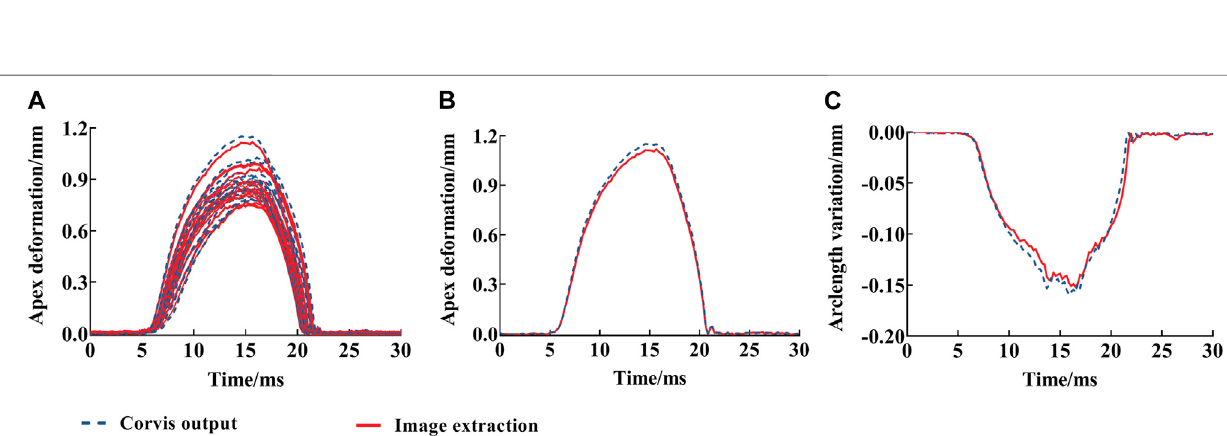
Frontiers in Bioengineering and Biotechnology |